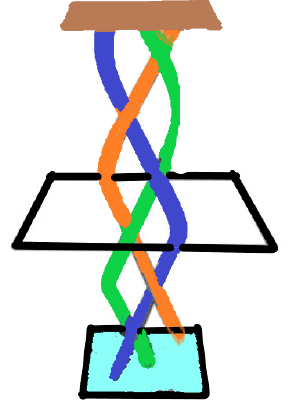
Figure 4. Tripartite Borromean